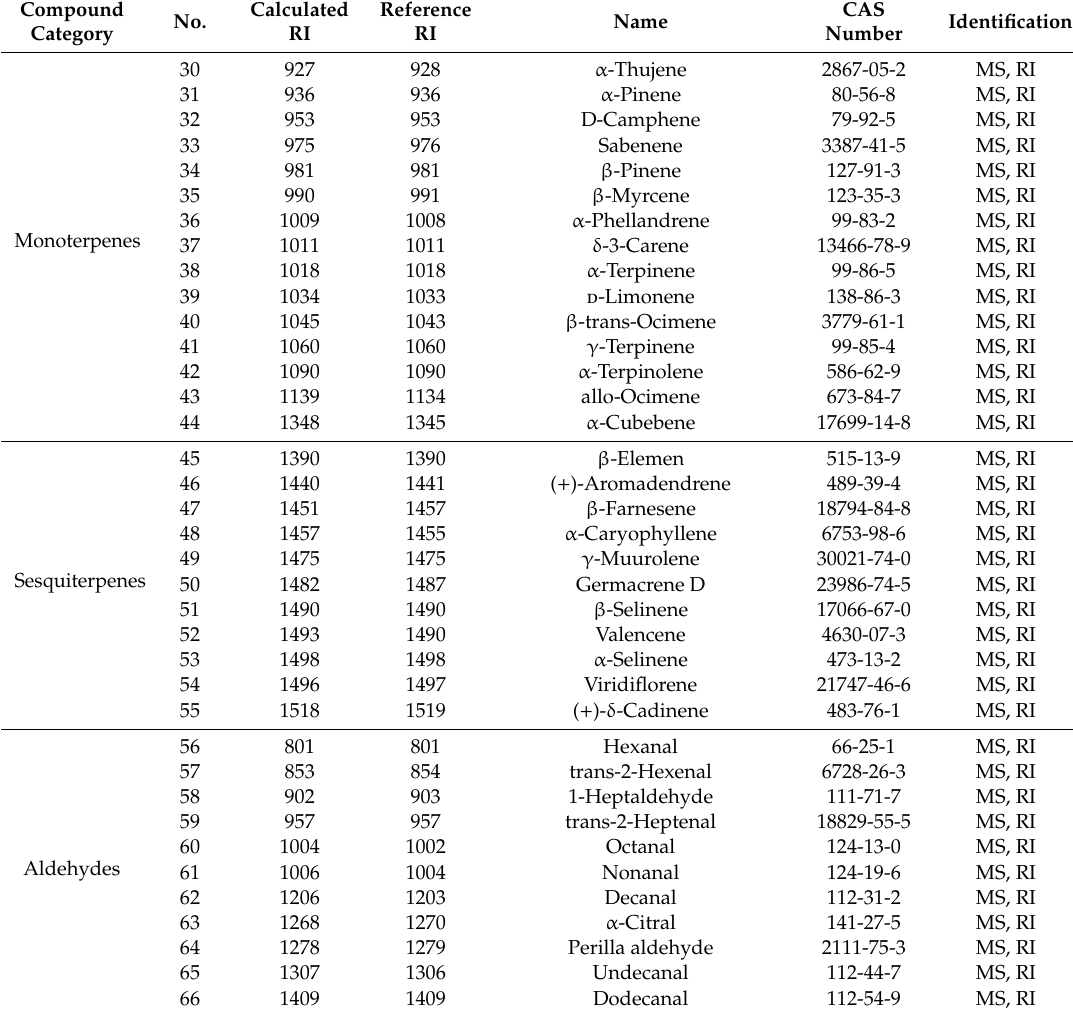
Table 2. Common volatile organic compounds identified in sweet orange juices and mandarin juices. Compound